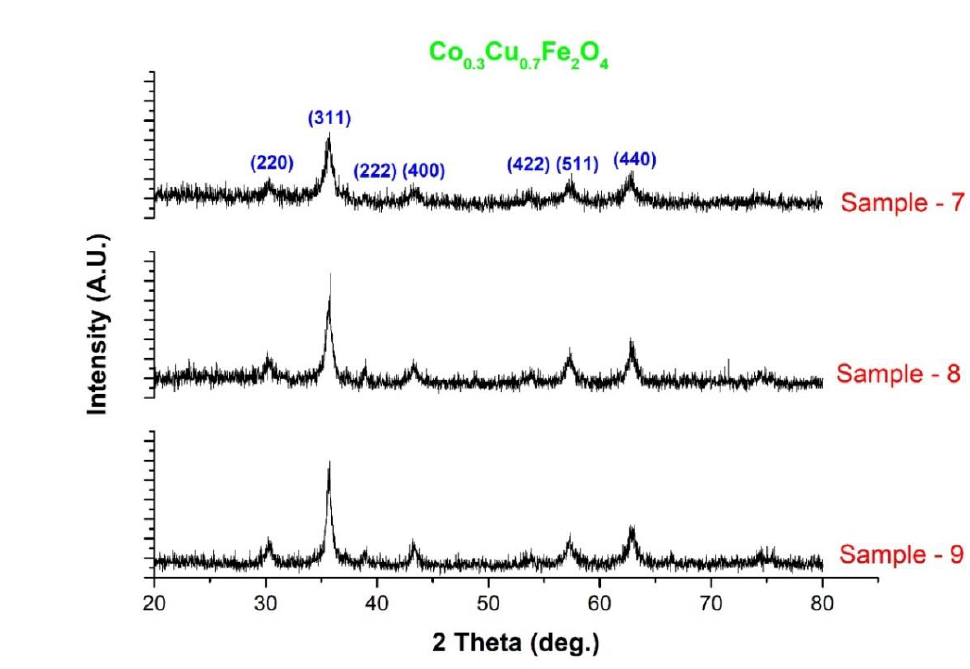
Fig.3-III: XRD pattern of sample – 7 (T=100 o C, t=8h), sample – 8 (T=150 o C, t= 8h), sample – 9 (T=200 o C, t= 8h). Table 1: XRD pattern analysis of the nine Co spacing between crystal plans, lattice constant, average crystallite size and density of